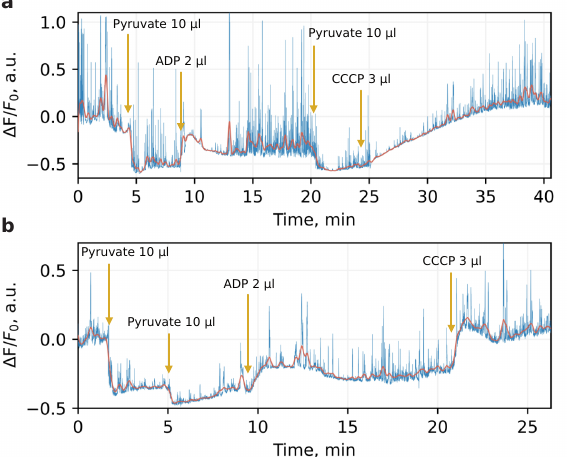
Figure 1. Changes in fluorescence 130 nM TMRM loaded with mitochondria isolated in sucrose ( a ) and phosphate ( b ) medium. A mixture of mitochondria suspension of 150 µ L and 1 µ L of TMRM was exposed to pyruvate (10 µ L), ADP (2 µ L), and CCCP (3 µ L) action. The difference between the membrane potential reaction to the respiration activation by substrate, its decrease during ATP production, and the loss due to induced proton permeability by CCCP are clearly visible (note that the dye fluorescence decreases with the increase in the potential). The dye fluorescence was excited with a 532 nm laser and collected with the same optics as the SiV